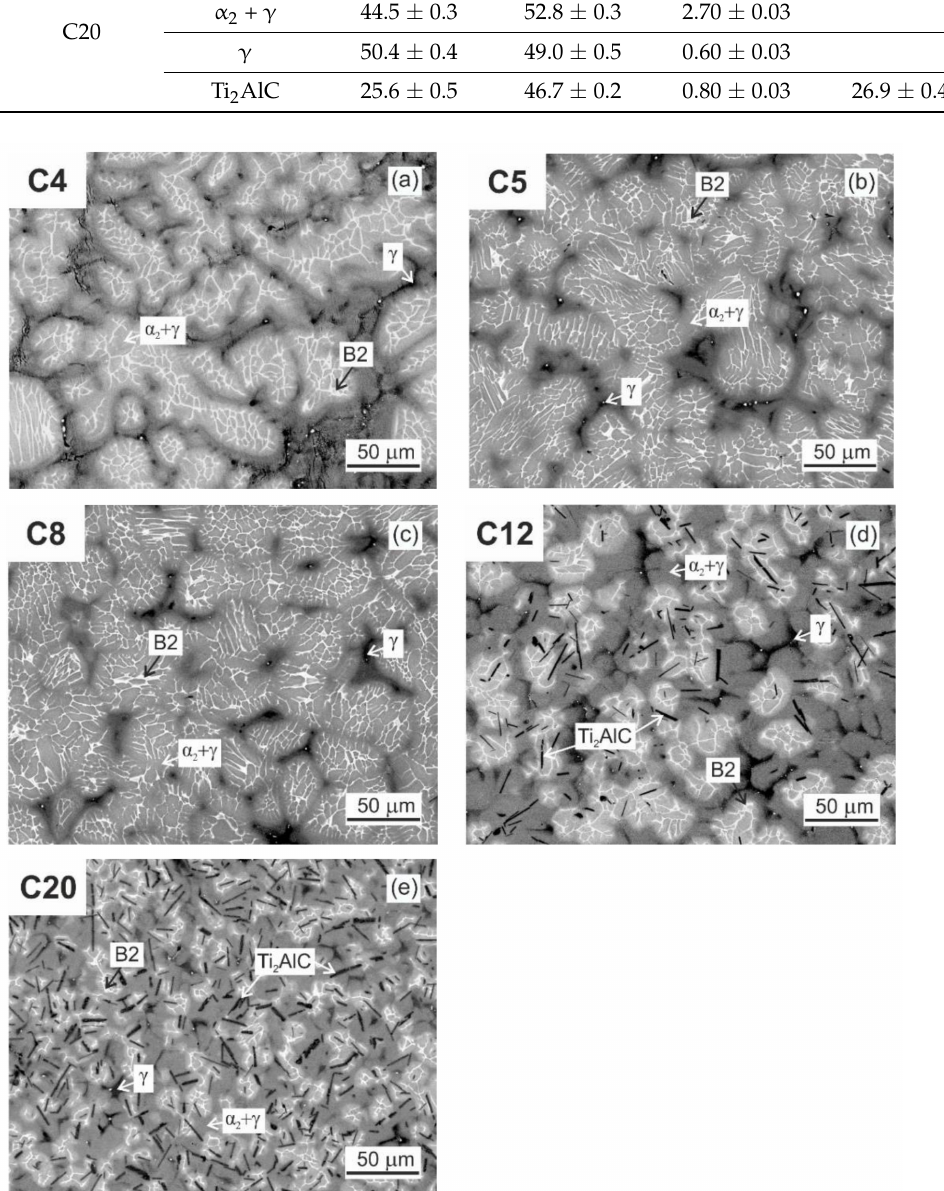
Figure 4. BSE micrographs showing the typical microstructue of the as-cast alloys: ( a ) C4; ( b ) C5; ( c ) C8; ( d ) C12; ( e )